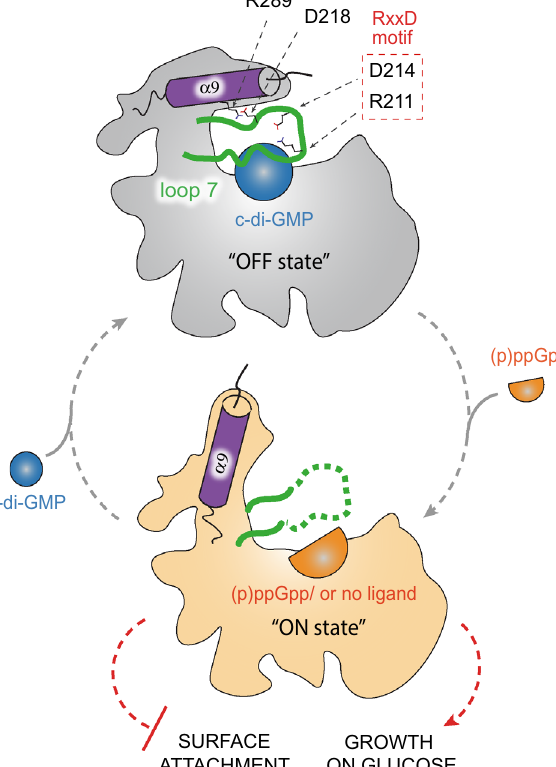
Figure 1. Second messenger mediated regulation of SmbA. Binding of a c-di-GMP dimer (blue sphere) inactivates SmbA (“OFF state”, grey), while its dissociation or displacement by a ppGpp monomer (an orange half-sphere) activates the protein (“ON state”, light orange). Loop 7 is shown in green, the C-terminal α9 helix is represented by a magenta cylinder. Amino acid residues essential for salt bridge formation between α9 helix and loop 7 are indicated. Key residues of the RxxD motif in loop 7 are shown in the red box. The physiological functions of activated SmbA are indicated with red dashed lines (Adopted from Shyp et al. 31